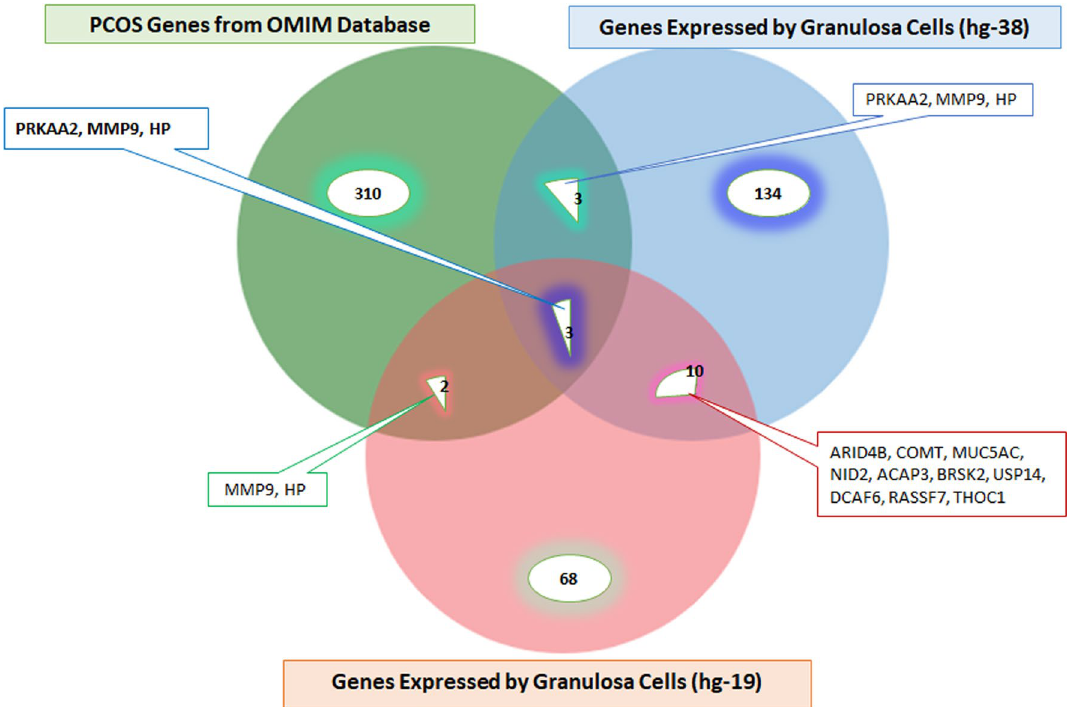
Fig. 3 Venn Diagram of Mural and Cumulus Granulosa Cells in Relations to identified PCOS Genes. The Venn diagram illustrating the connections between the genes that are expressed by the Mural and Cumulus Cells in this GWAS analysis and the PCOS